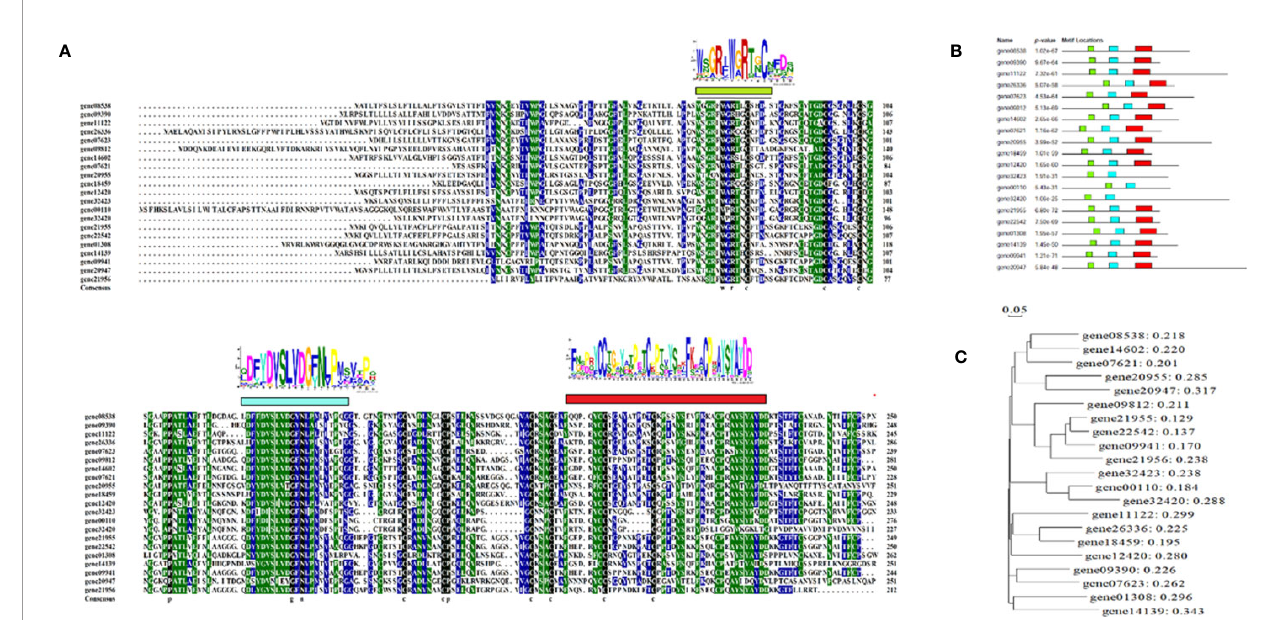
FIGURE 4 | Characterization of the osmotin-like proteins (OLP) family. (A) Sequence alignment of the OLP protein family. The deduced amino acid sequences of OLPs were aligned using DNAMAN software (v 6.0) with default settings. Logos above the alignment are the conserved domains searched by the Motif-based sequence analysis tools (The MEME Suite 5.1.1, http://meme-suite.org/index.html). (B) motif locations for each OLP member. (C) phylogenetic analysis of OLP proteins by DNAMAN software